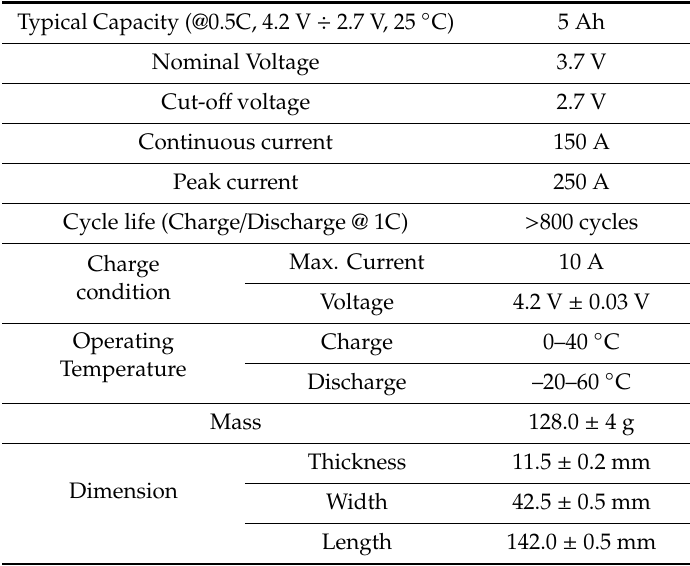
Table 1. Main characteristics of the battery